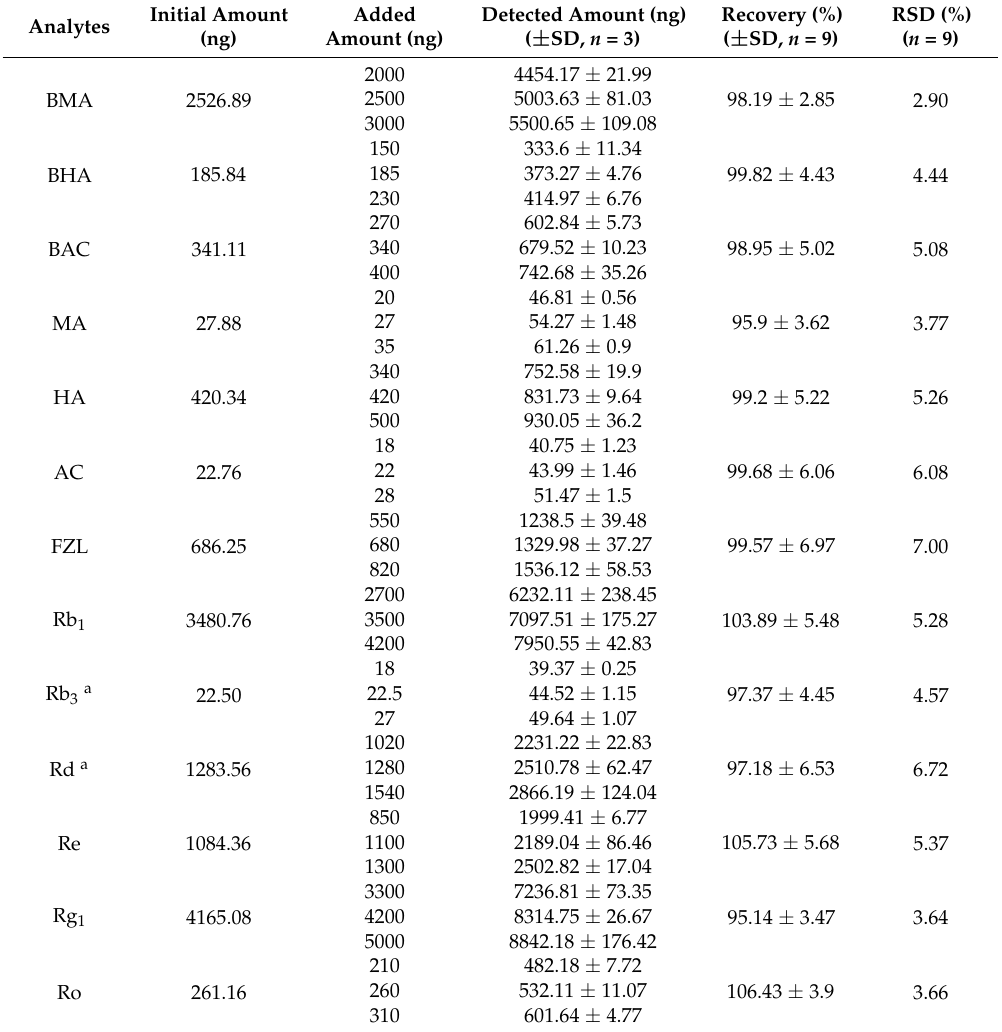
Table 5. Recovery of 13